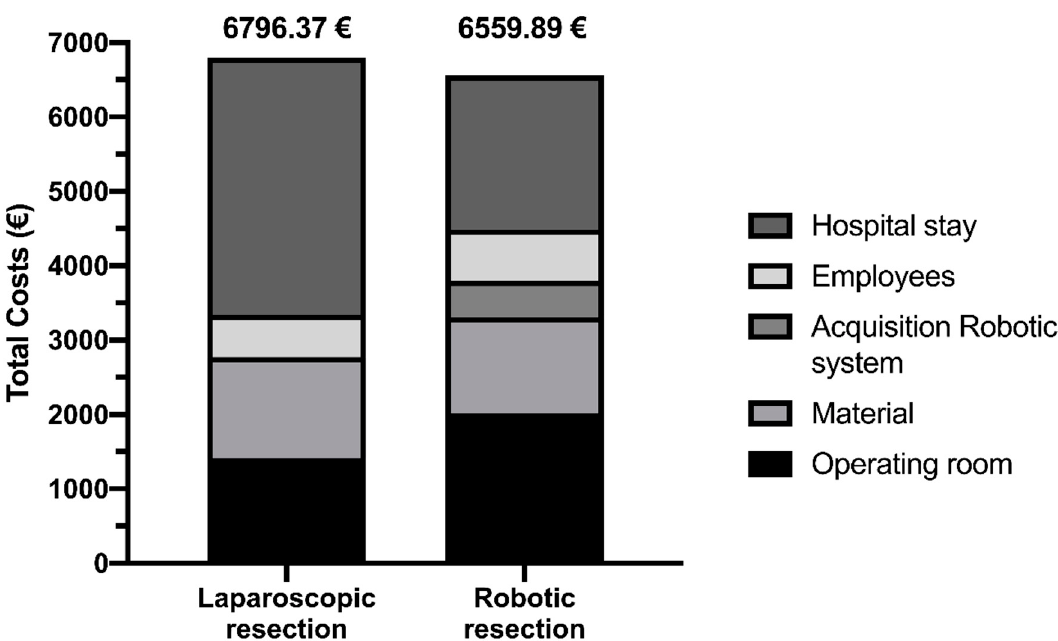
Figure 2. Cost-effectiveness. Table 5. Cost-effectiveness